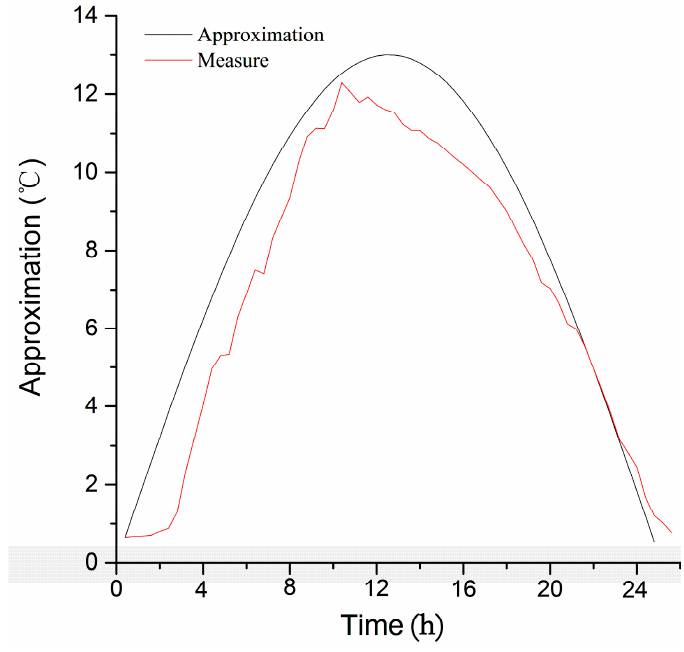
Figure 2. Measured and simulated temperature change curves.